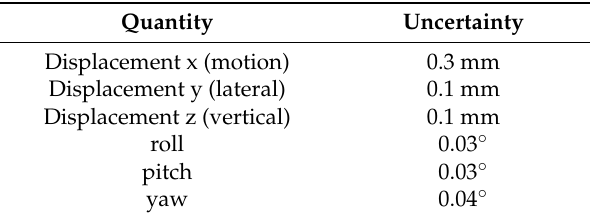
Table 1. Summary of the uncertainties obtained with the proposed